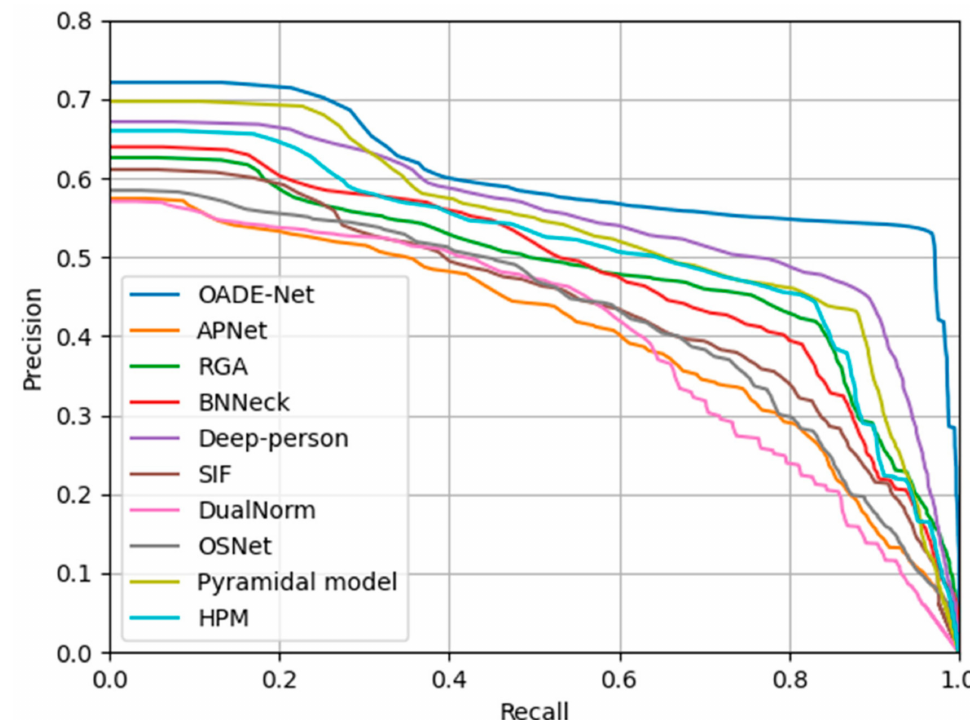
Figure 11. Graphs of precision versus recall of the proposed and state-of-the-art methods with DBPerson-Recog-DB1.